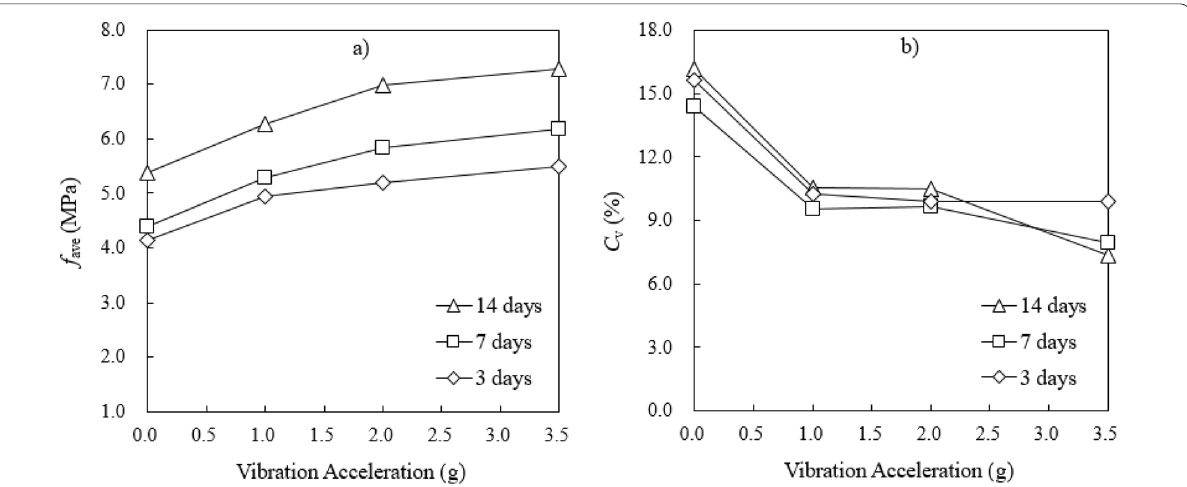
Fig. 5 UCS versus vibration acceleration under different curing ages for CSM with 5% cement dosage. a UCS; b coefficient of variation of